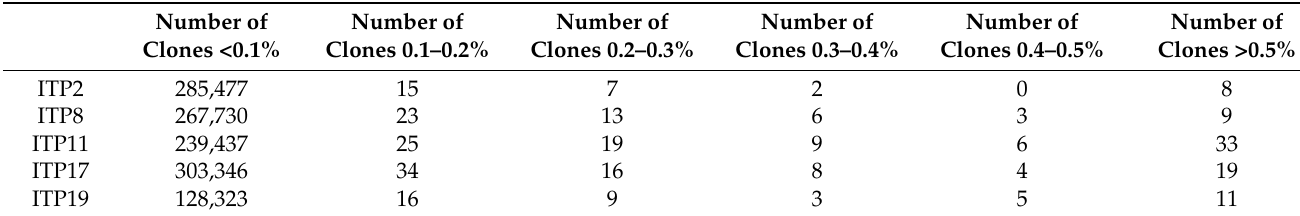
Table 4. The distribution of CD8+ T cell repertoire in peripheral blood before